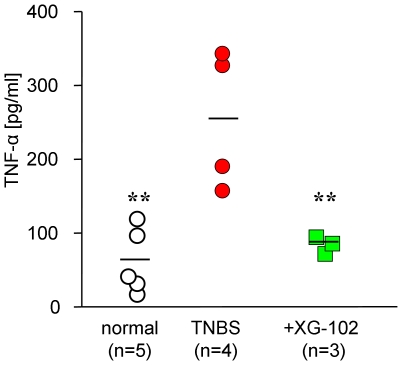
Production of TNF-α.TNF-α release (pg/ml) into the supernatant of organic colon culture from normal mice, following trinitrobenzene sulfonic acid (TNBS) only, and treatment with sc. 100 µg/kg XG-102. ** = p<0.01 for all groups compared with TNBS group.